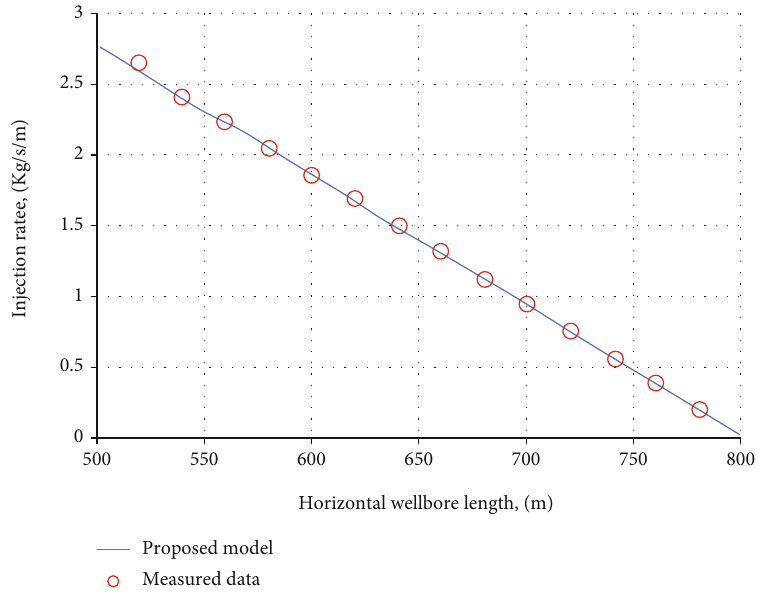
Figure 7: Steam injection rate along the horizontal wellbore.